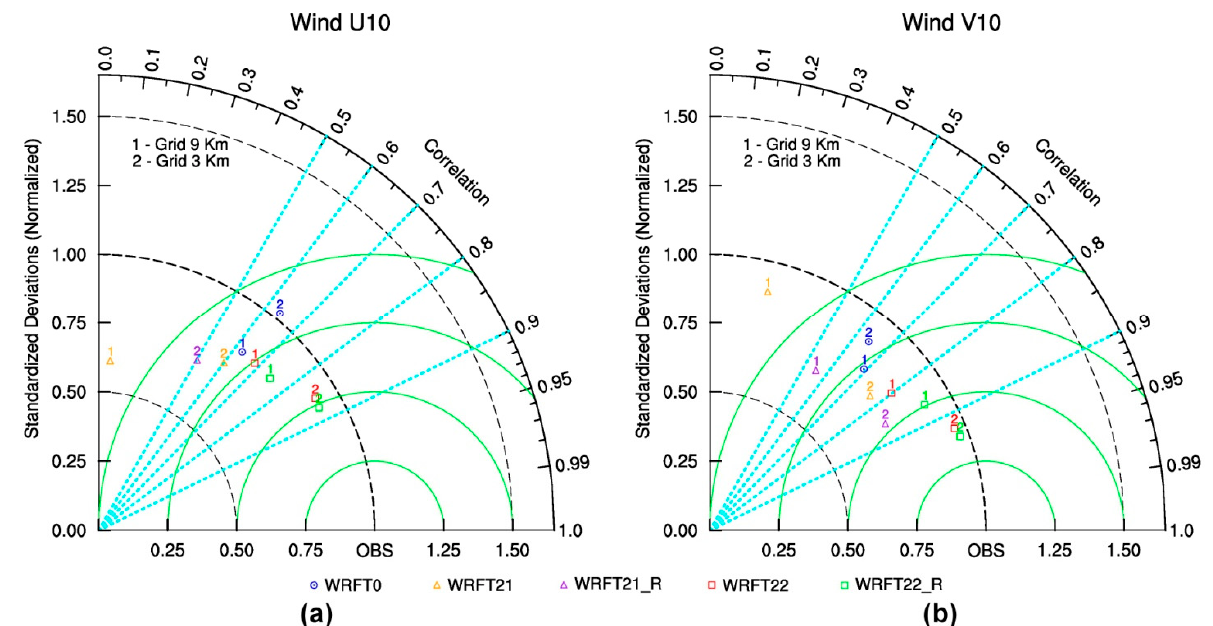
Figure 10. Taylor diagrams for zonal (panel ( a )) and meridional (panel ( b )) wind components, with statistics normalized with respect to observations. Numbers 1 and 2 indicate the outer grid (9 km) and the inner grid (3 km), respectively. The blue circle identifies the control run. The orange triangle and red square identify runs with data assimilation until 21:00 UTC and 22:00 UTC on 12 November 2019, respectively, while the corresponding runs, with the adjustment of the acquisition time window, are identified by the purple triangle and green square, respectively.